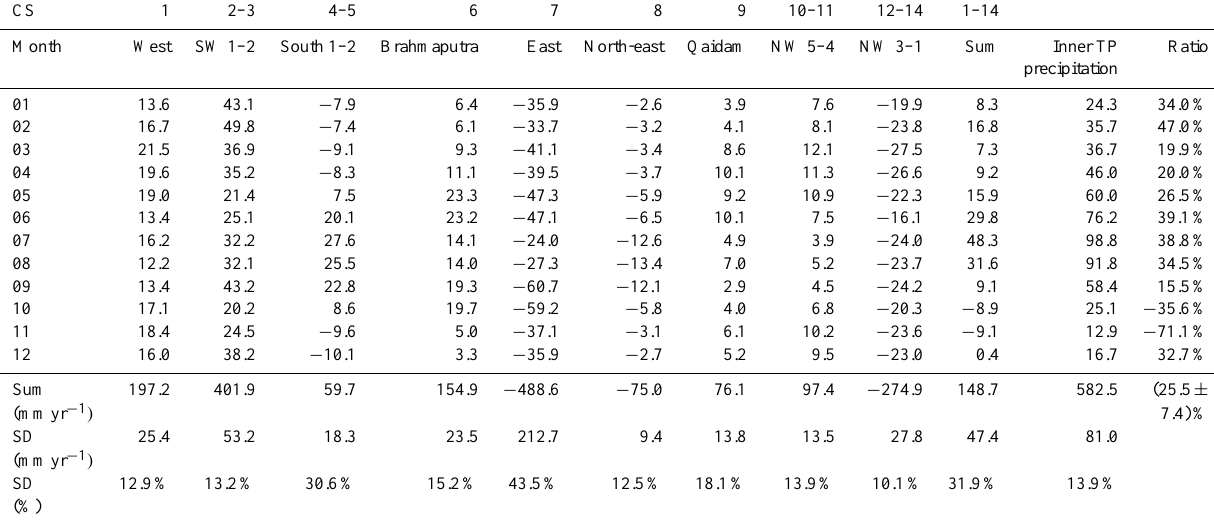
Table 2. The same as Table 1 but for